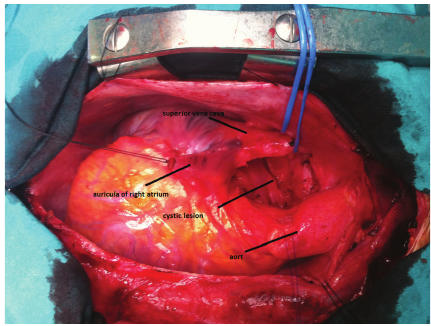
Figure 2: Perioperative view of the cyst.